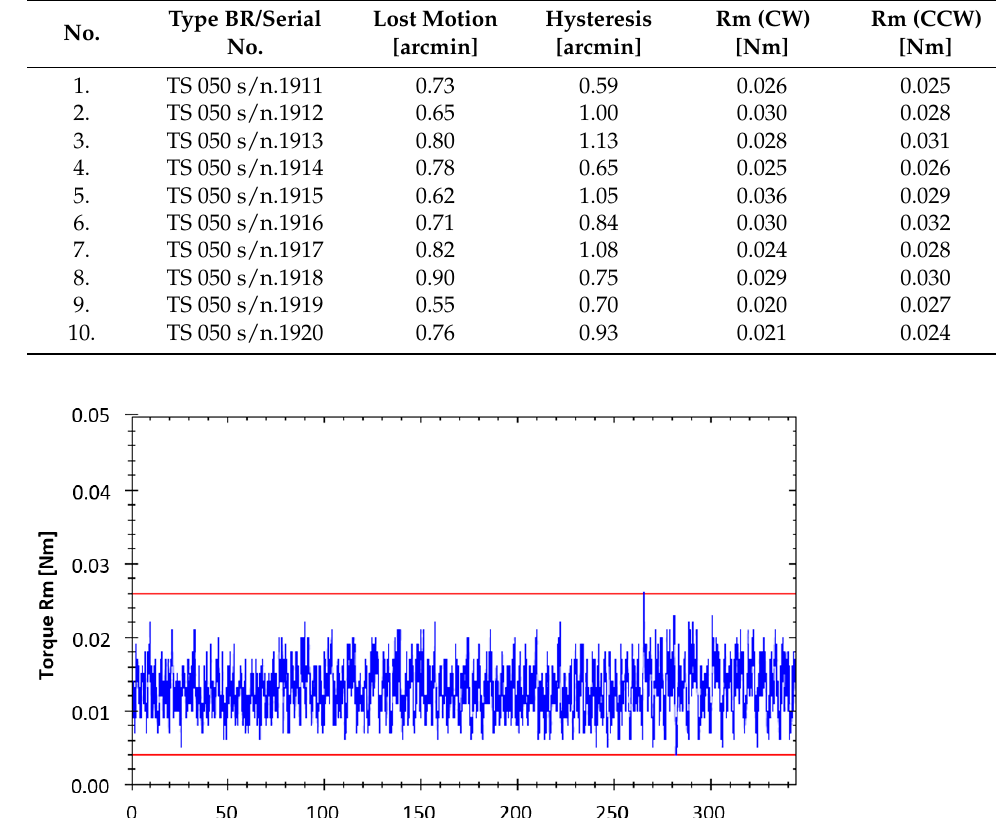
Table 10. Bearing reducer TS 050 parameters measured after the trial run (configuration B).